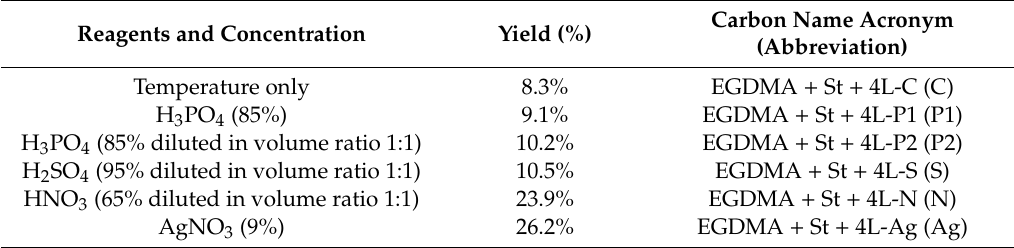
Table 6. Characteristics of the carbonization process.